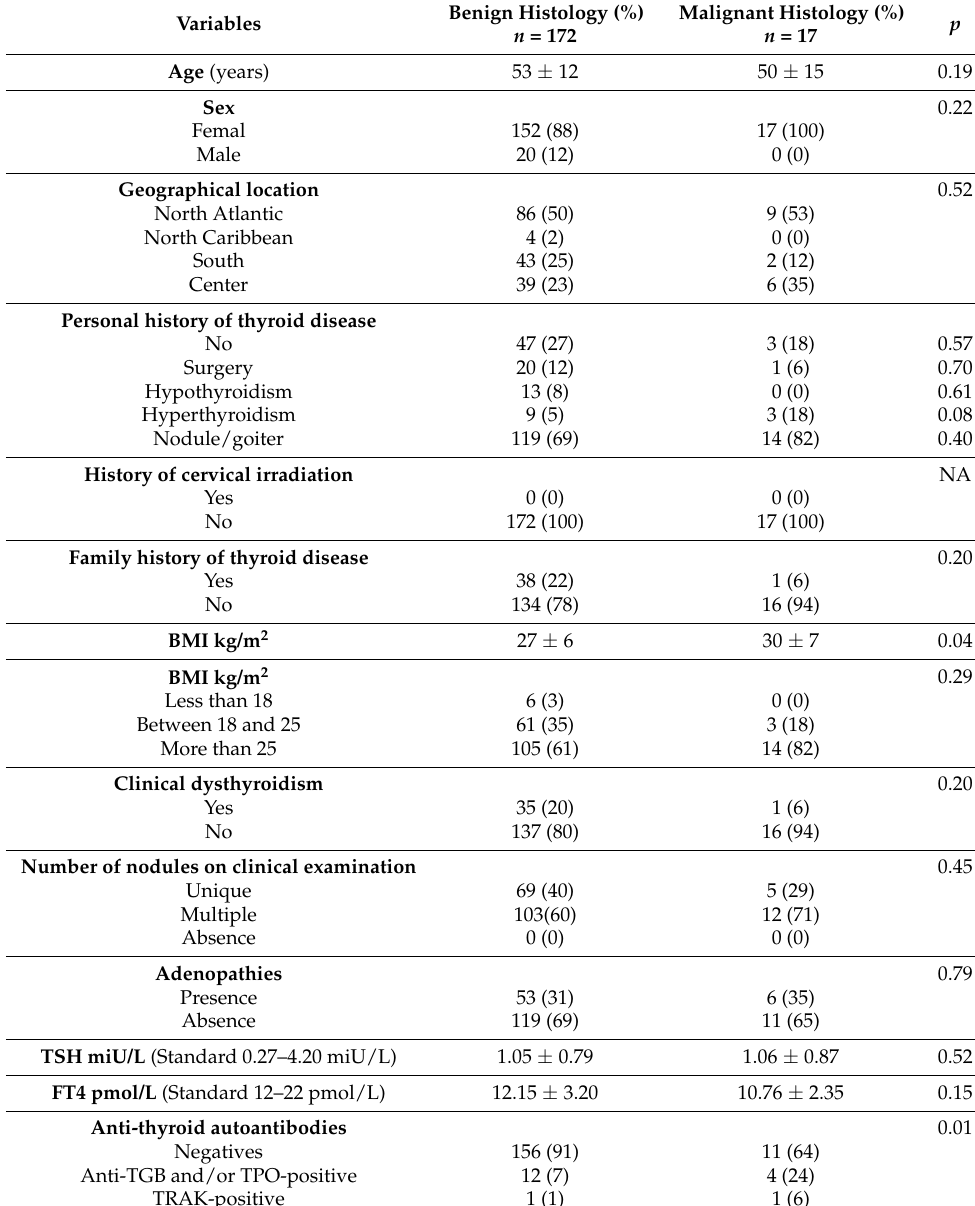
Table 1. Characteristics of patients by histological